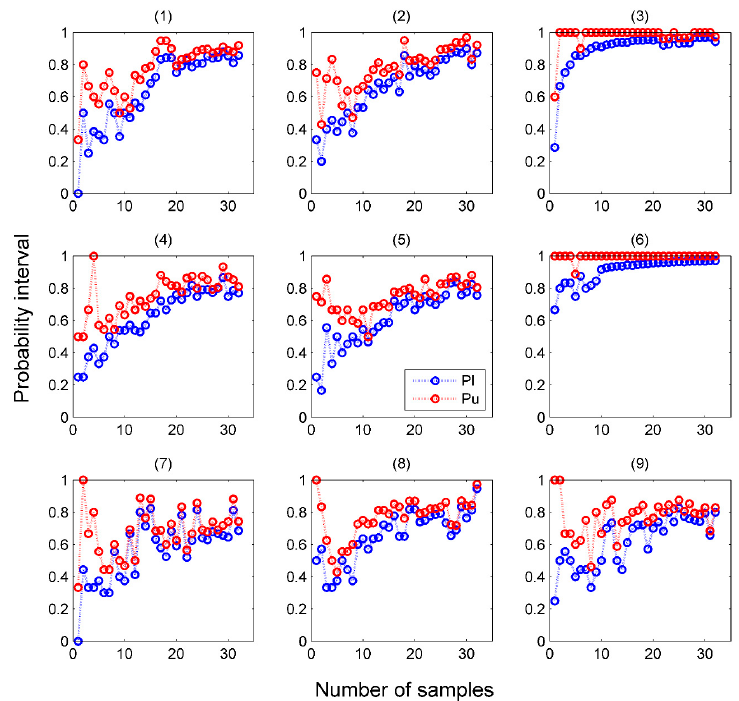
Figure 4. Change of precision of predicted probability intervals for samples from category ( 1 – 9 ) during online prediction process with VM-SVM.